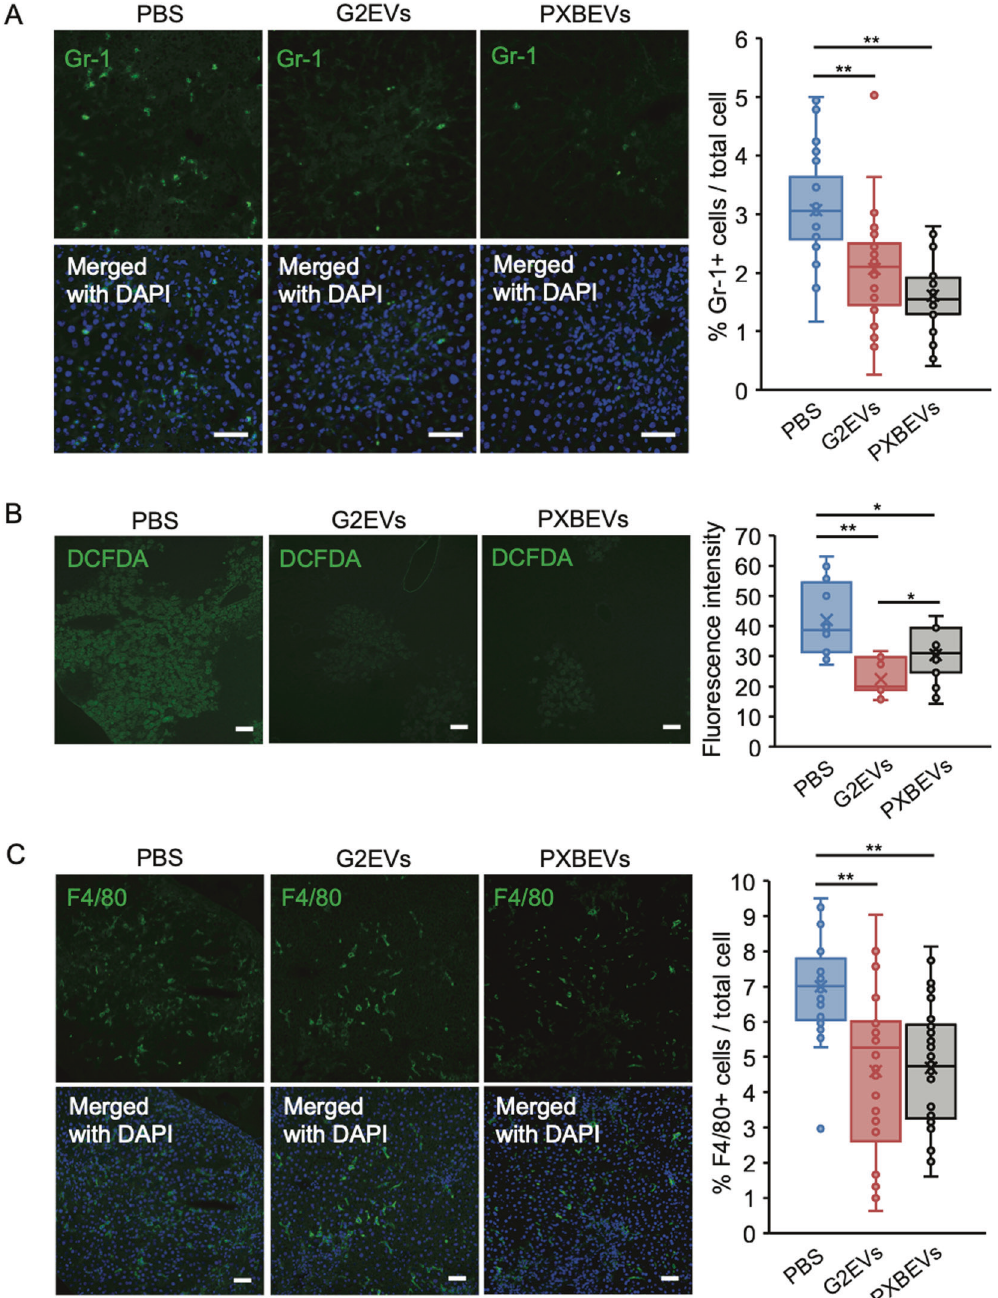
Fig. 5 Hepatocyte-derived EV treatment reduced Gr-1 positive neutrophil and F4/80 positive cell in fi ltration into the liver. A Gr-1 (green) and DAPI (blue) staining of liver sections of the mice treated with CCL 4 + PBS, CCL 4 + HepG2-EVs, or CCL 4 + PXB-EVs. Gr-1 positive cells were enumerated in 10 fi elds from 3 mice. Ratio to total cells was calculated. B ROS (green) staining using 2 ′ ,7 ′ -dichloro fl uorescenin diacetate (DCFDA) and DAPI (blue) staining of liver sections of the mice treated with CCL 4 + PBS, CCL 4 + HepG2-EVs, or CCL 4 + PXB-EVs. Fluorescent intensity was measured in 10 fi elds from 3 mice using ImageJ. C F4/80 (green) and DAPI (blue) staining of liver sections of the mice treated with CCL 4 + PBS, CCL 4 + HepG2-EVs, or CCL 4 + PXB-EVs. F4/80 positive cells were calculated in 10 fi elds from 3 mice. Ratio to total cells was calculated. Statistical analysis was performed using one-way ANOVA and subsequent Tukey ’ s HSD method. * P < 0.05, ** P < 0.01. White bars indicate 50 μ